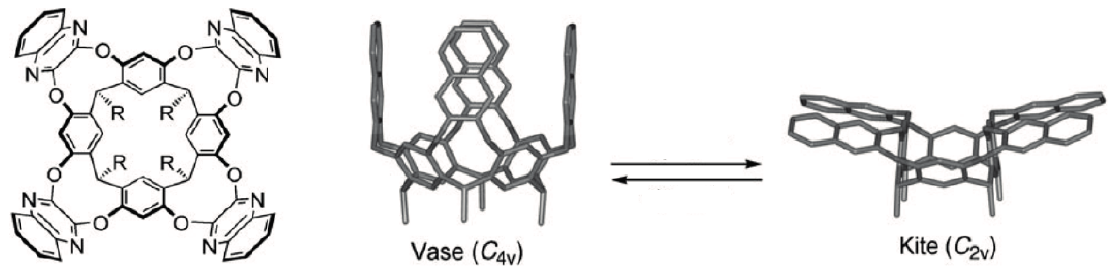
Figure 4. Cavitands which switch between close “vase” and open “kite” conformations [13].